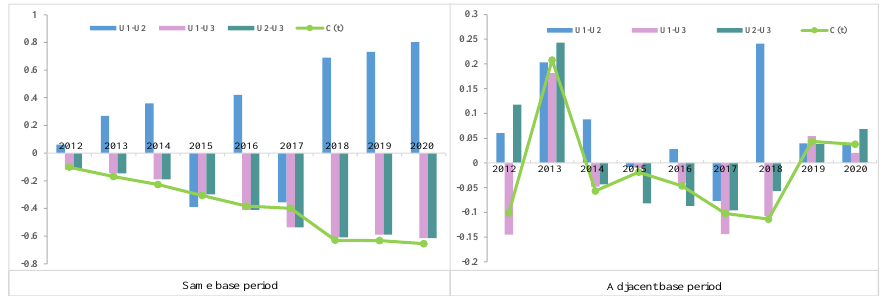
Figure 6. Synergy degree of two-two subsystem of logistics industry ESE-B.